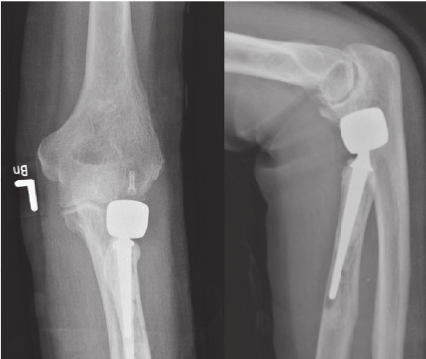
Figure 3: On postoperative X-ray, the MAGNEZIX CS can be identified as mildly radiopaque structure.